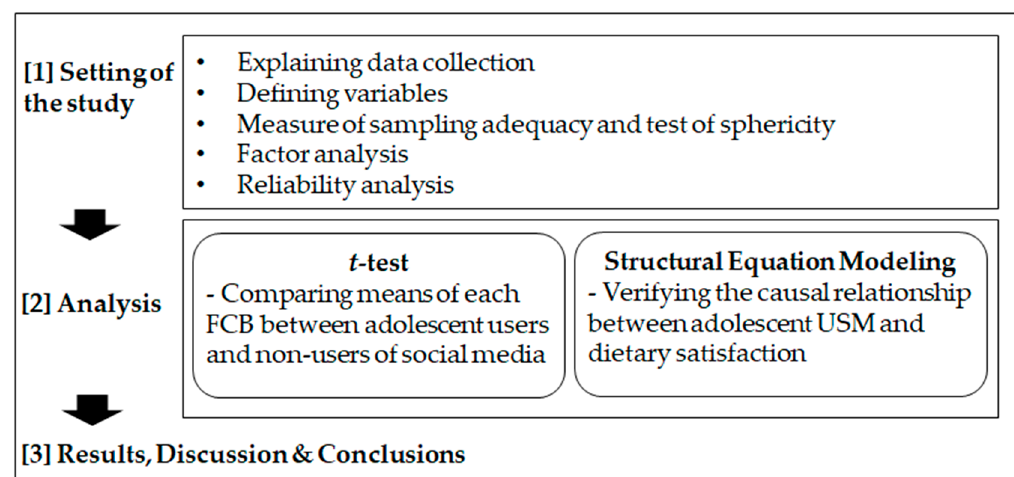
Figure 2. Research procedure of the study.